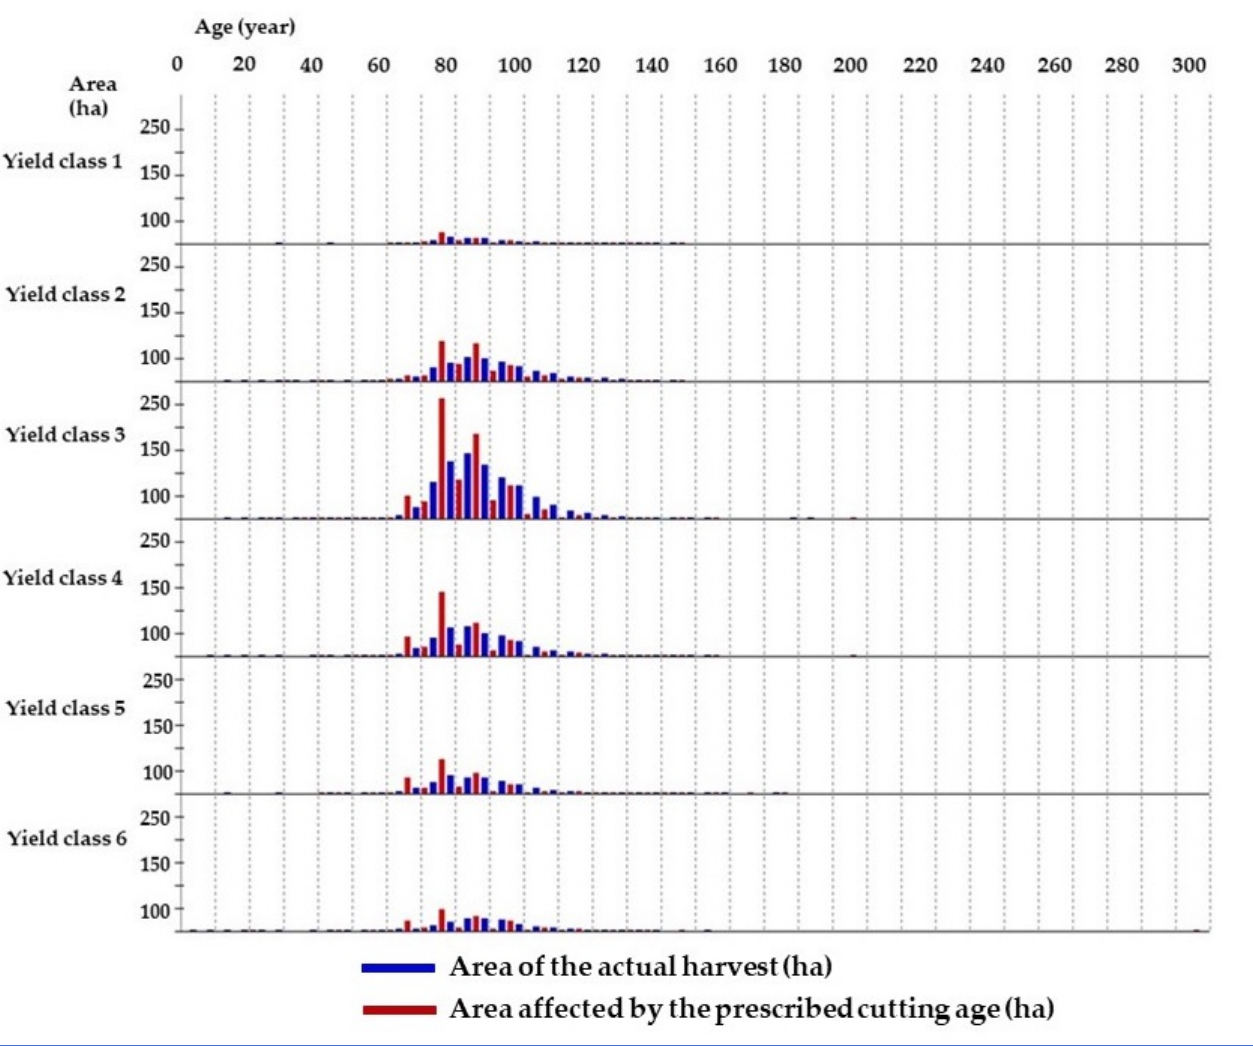
Figure 6. Average area of the 2006–2021 period to be harvested according to the prescribed cutting age and area of the actual harvests of Turkey oak ( Quercus cerris ) stands as the function of the age and grouped by yield classes.